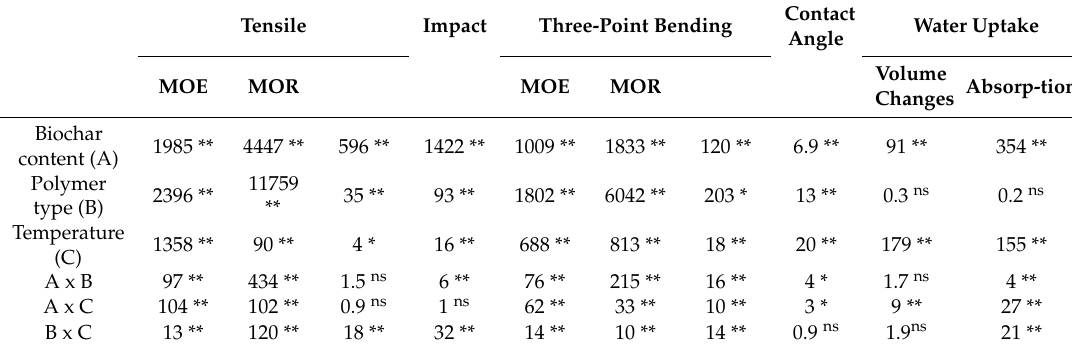
Table 3. Results of the analysis of variance (F-value) for mechanical and physical properties of biochar